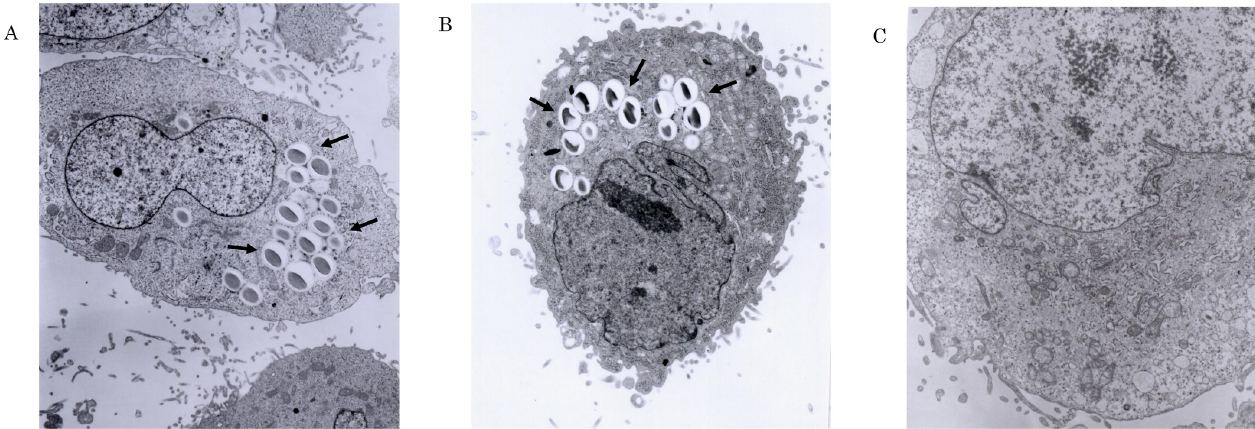
Fig 3. HeLa cells uptake assay of protein-coated polystyrene latex microbeads by electron microscopy. Monolayer-cultured HeLa cells and the truncated protein-coated beads and BSA-coated beads were allowed to react for 5 h, and the entry of beads into HeLa cells were observed under an electron microscope. As shown in the arrow, (A) r-lep37 kDa protein-coated beads and (B) r-lep27 kDa protein-coated beads were observed to enter into HeLa cells, but (C) BSA- coated beads were not observed to enter into HeLa cells. Magnification × 3500 (A), × 5000